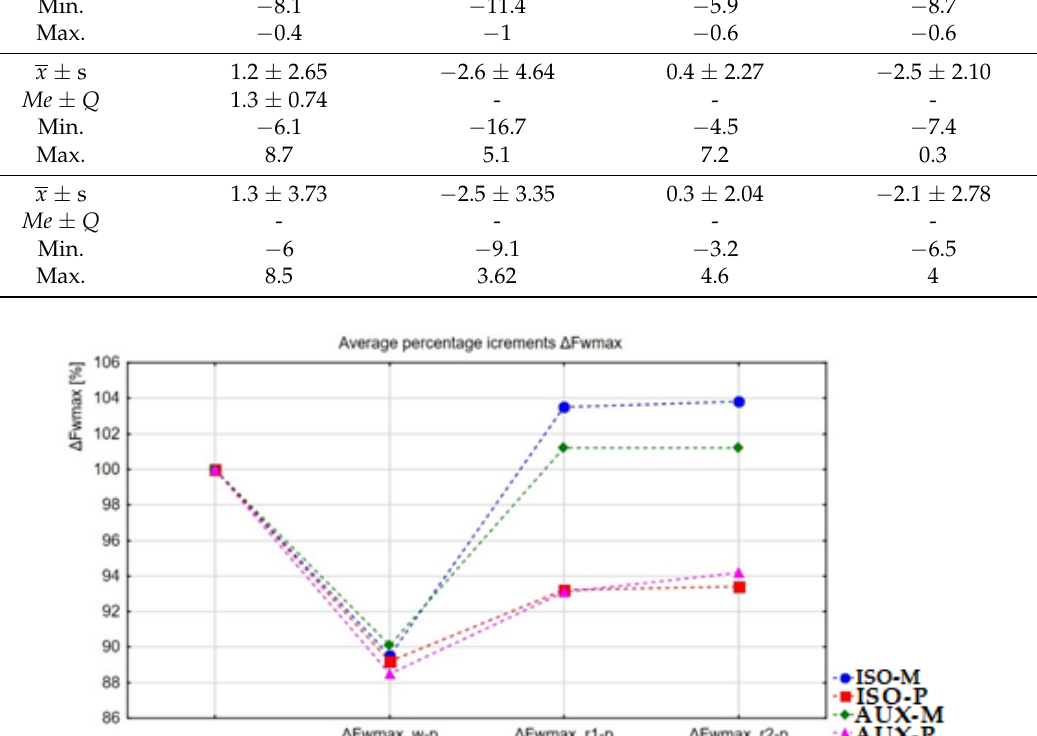
Figure 3. Graphical representation of changes in the maximum relative strength compared to baseline expressed in % in individual periods of the experiment in groups of participants. ∆ Fwmax_w-p—post- exercise change in relative strength following exercise relative to baseline, ∆ Fwmax_r1-p—change in relative strength after the first recovery period, relative to baseline, ∆ Fwmax_r2-p—change in relative strength after the second recovery period, relative to baseline.